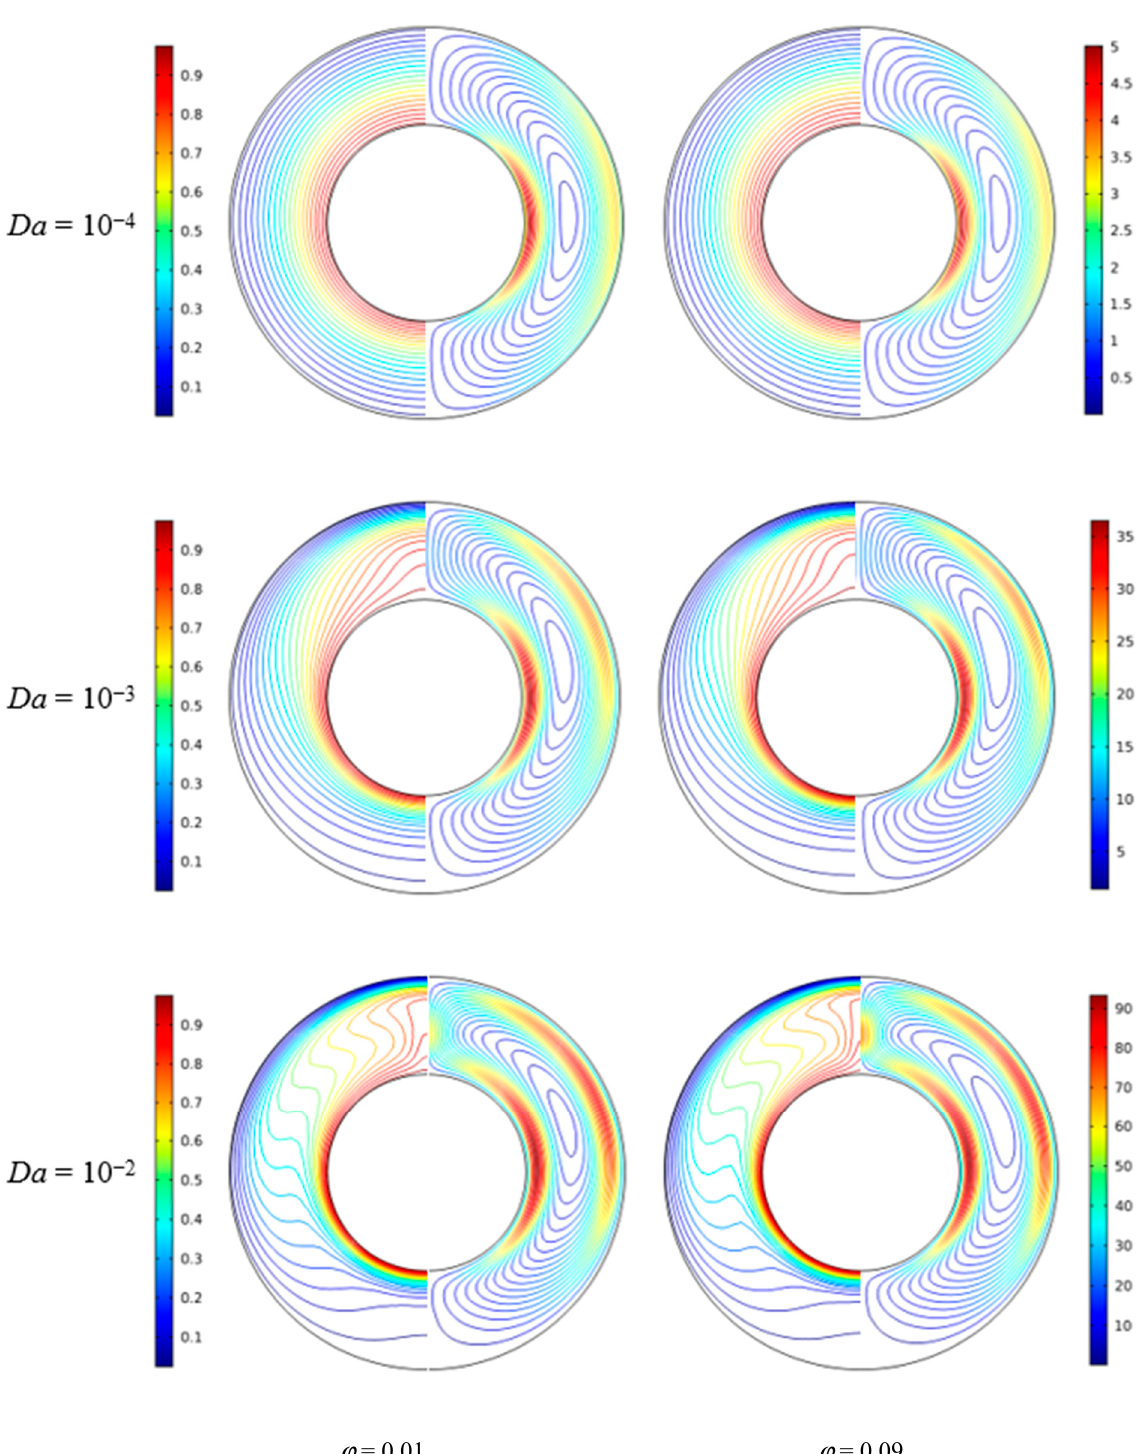
Figure 6. Isotherms (left) and streamlines (right) for Cu–water nanofluid for different nanoparticle volume fractions ( ϕ ) and Darcy numbers ( Da ) at Ra = 10 5 , d sp = 50 nm, ε = 0.5, and RR = 2.